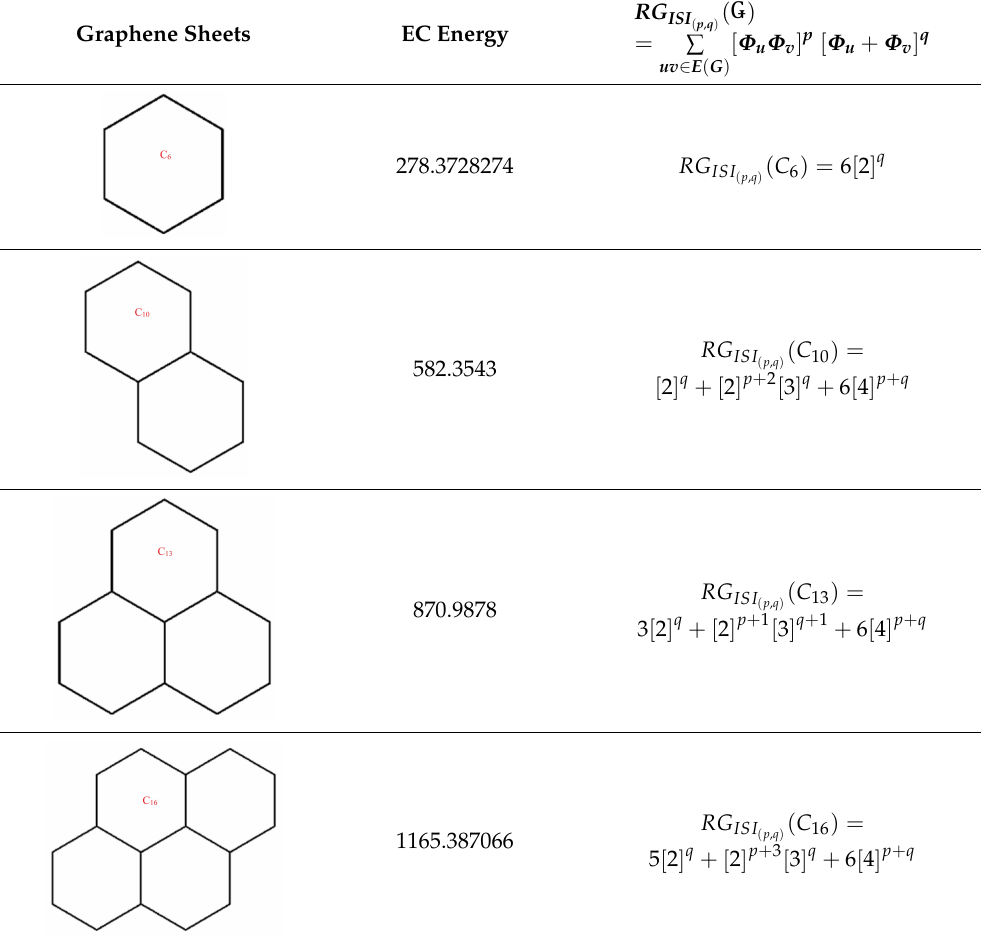
Table 1. Some reverse degree-based topological descriptors derived from the reverse general in- verse sum indeg